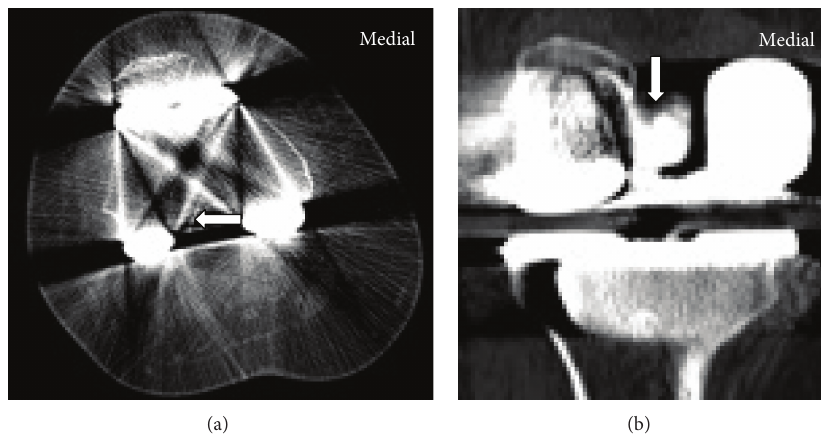
Figure 3: Cement in intercondylar notch (arrow) on CT